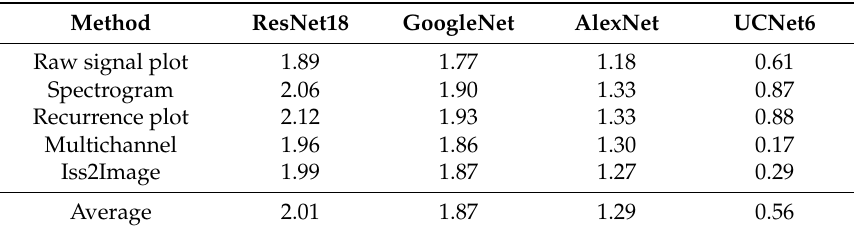
Table 11. Comparison of inference time (seconds) on different networks with 1000